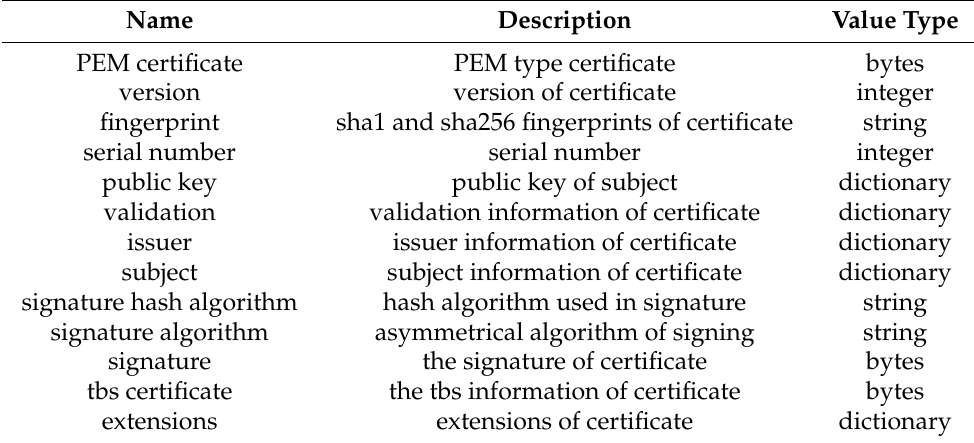
Table 1. Detail of basic fields of X.509